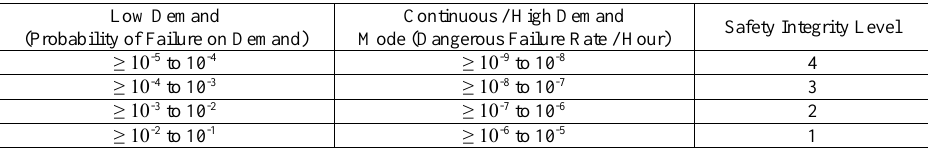
Table 1. Safety Integrity